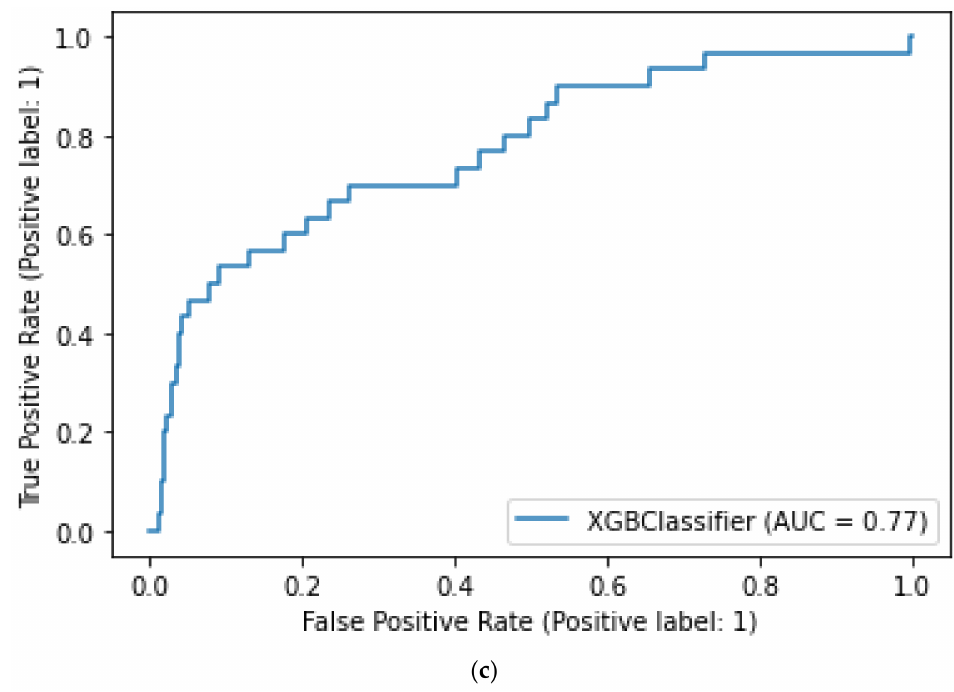
Figure 4. Panel ( a – c ) respectively contain the ROC-AUC plot related to Model 1, Model 2, and Model